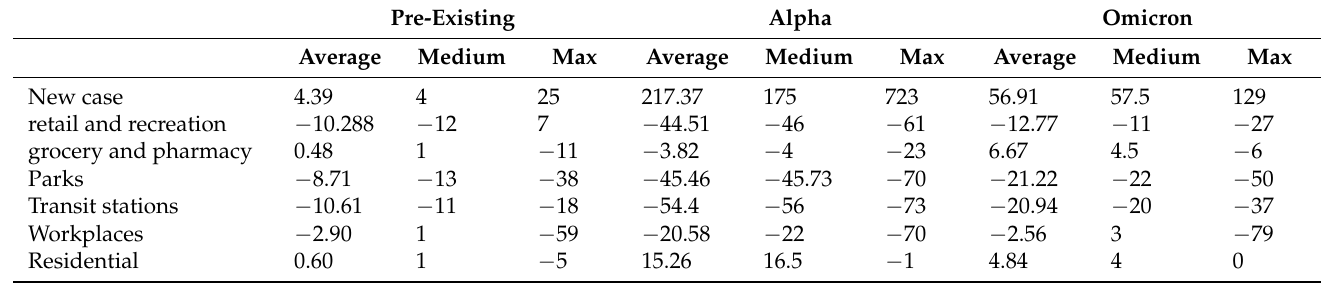
Table 1. The population flow change of each place in the Pre-existing epidemic, Alpha epidemic, and Omicron epidemic in Taiwan.